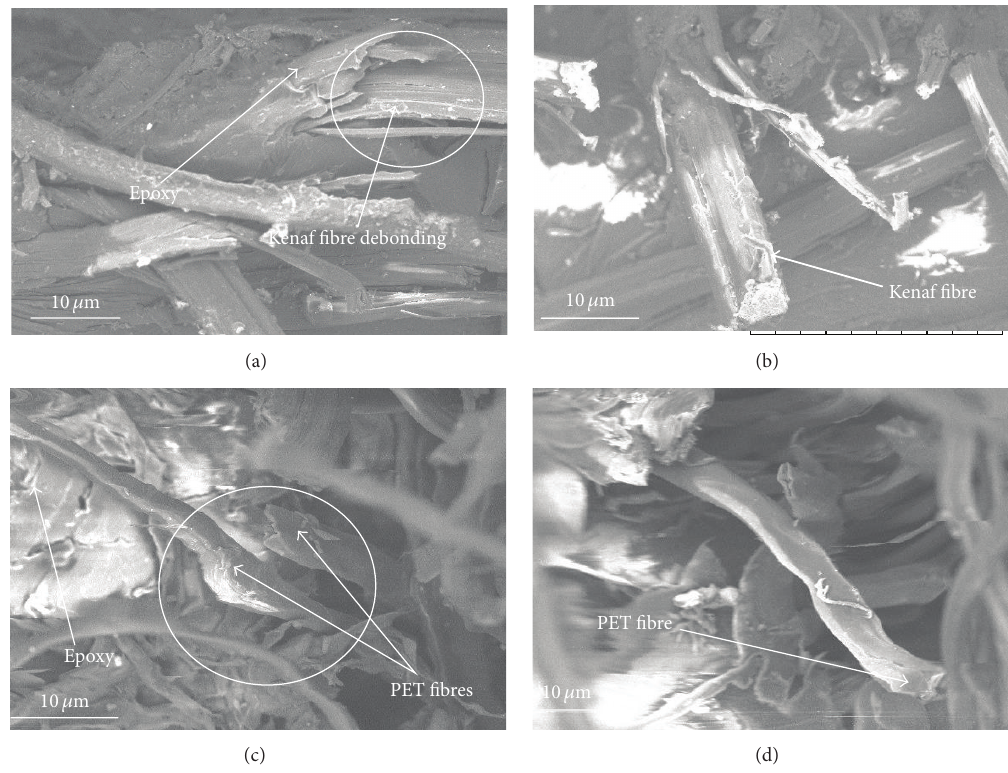
Figure 9: Kenaf and PET fibre morphology: (a) kenaf fibre bonding with epoxy matrix; (b) kenaf fibre morphology; (c) PET fibre bonding with epoxy; (d) PET fibre